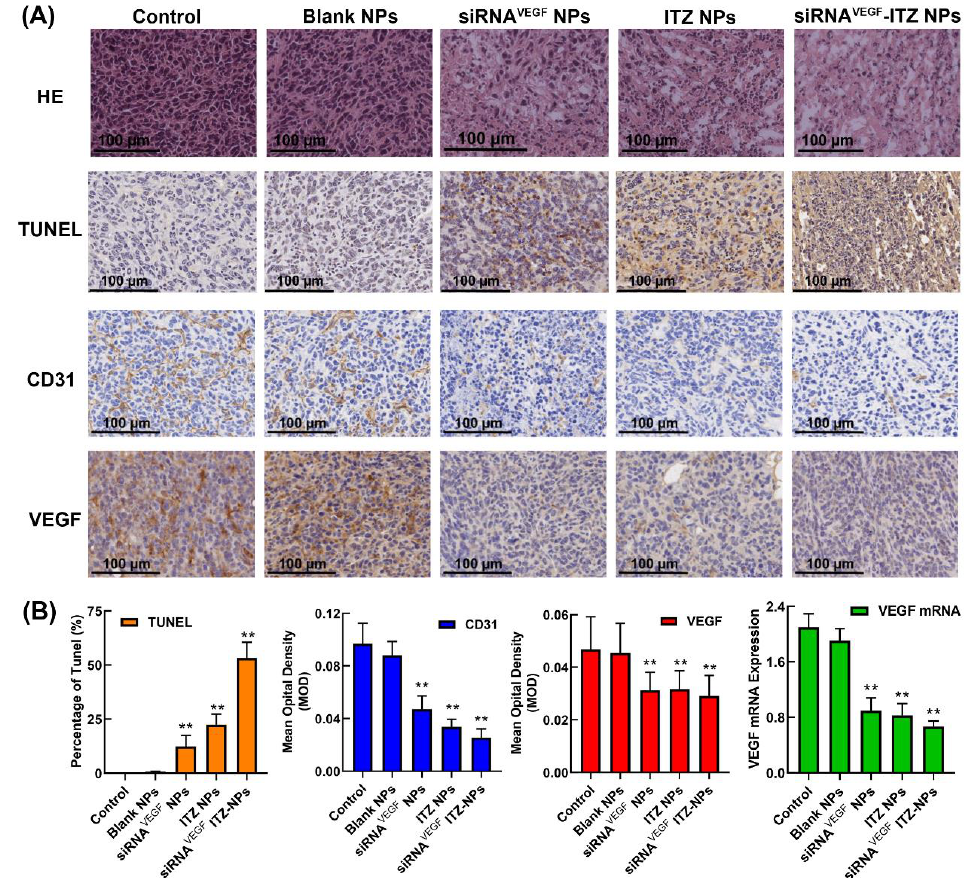
Figure 9. ( A ) Histological analysis of the tumor tissues after treatment. The HE, TUNEL staining, and immunofluorescence of CD31 and VEGF proteins in tumor tissues harvested from different groups. Scale bar = 100 µm. ( B ) Apoptosis rate (Percentage of TUNEL), quantitate analysis of CD31 and VEGF expression and tumor levels of VEGF mRNA after systemic administration of ITZ and VEGF siRNA co-delivery NPs (N/P = 30, C/N = 1/5; ITZ content: 8.28%) in 4T1 Luc tumor-bearing mice. ** p < 0.01 vs. saline ( n = 4).